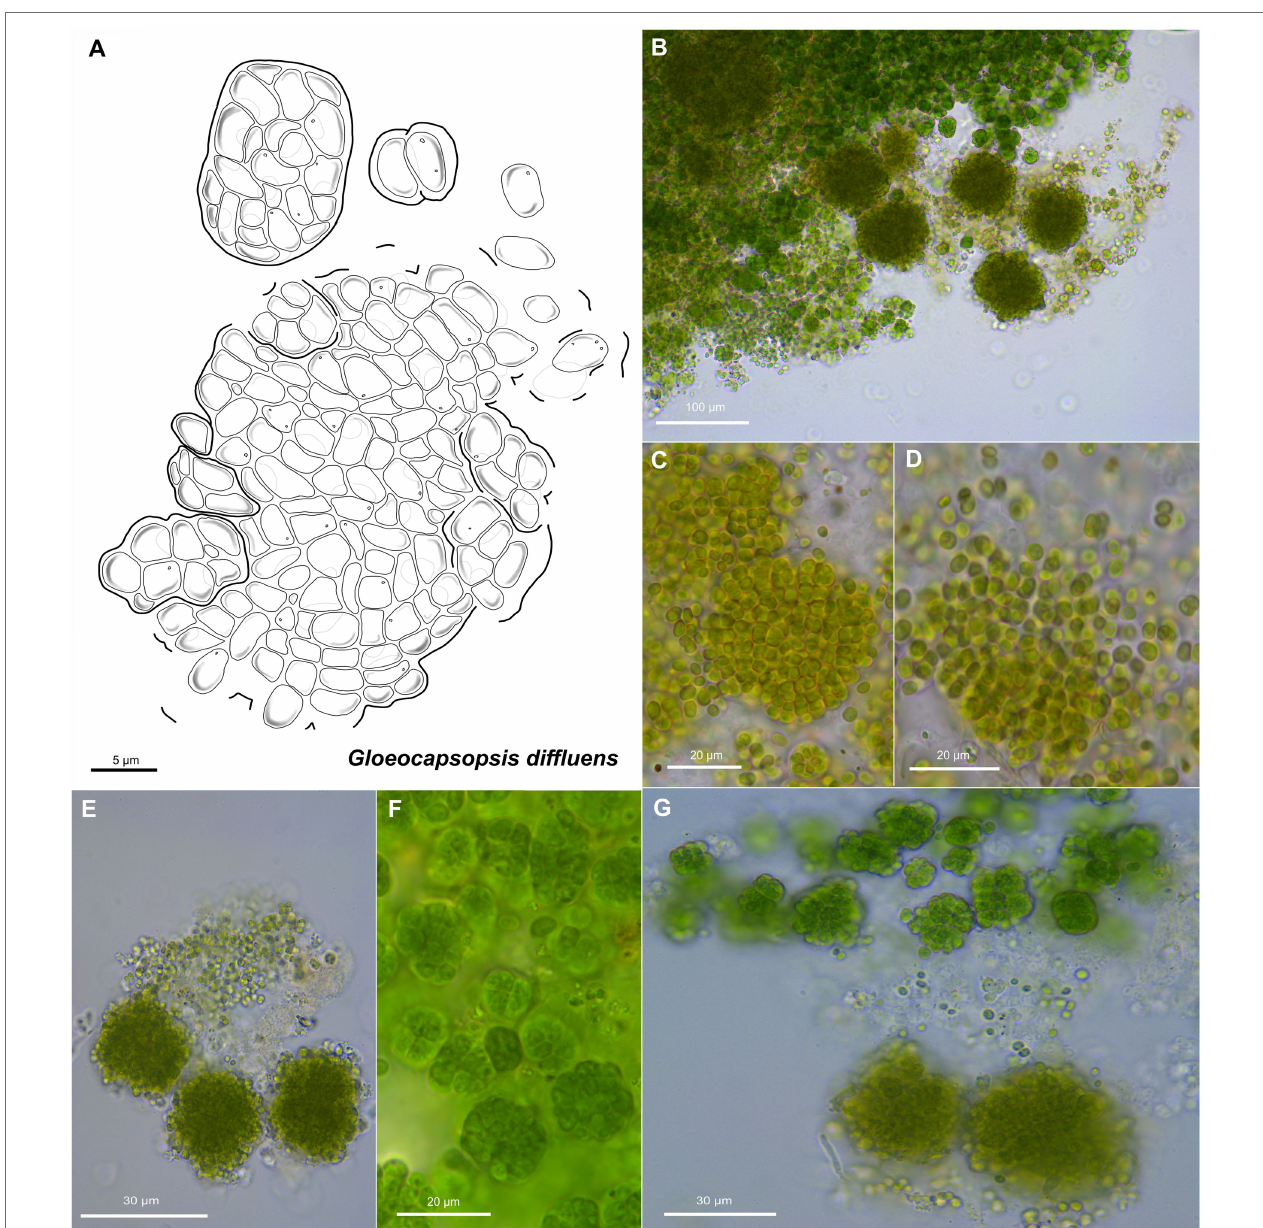
FIGURE 7 | Morphological characteristics of G. diffluens sp. nov. strain PJ S16. (A) Scheme summarizing the life cycle of G. diffluens . (B) Overview showing older brownish macrocolonies surrounded by young greenish colonies, made of smaller cell aggregates and single cells. (C) Coleochaete -like growth of older colonies. (D,E) show older colonies with diffluent and interrupted sheaths releasing unsheathed single cells. (F) shows various aggregates in a young culture. (G) depicts older brownish macrocolonies surrounded by young greenish colonies made of smaller cell aggregates and single